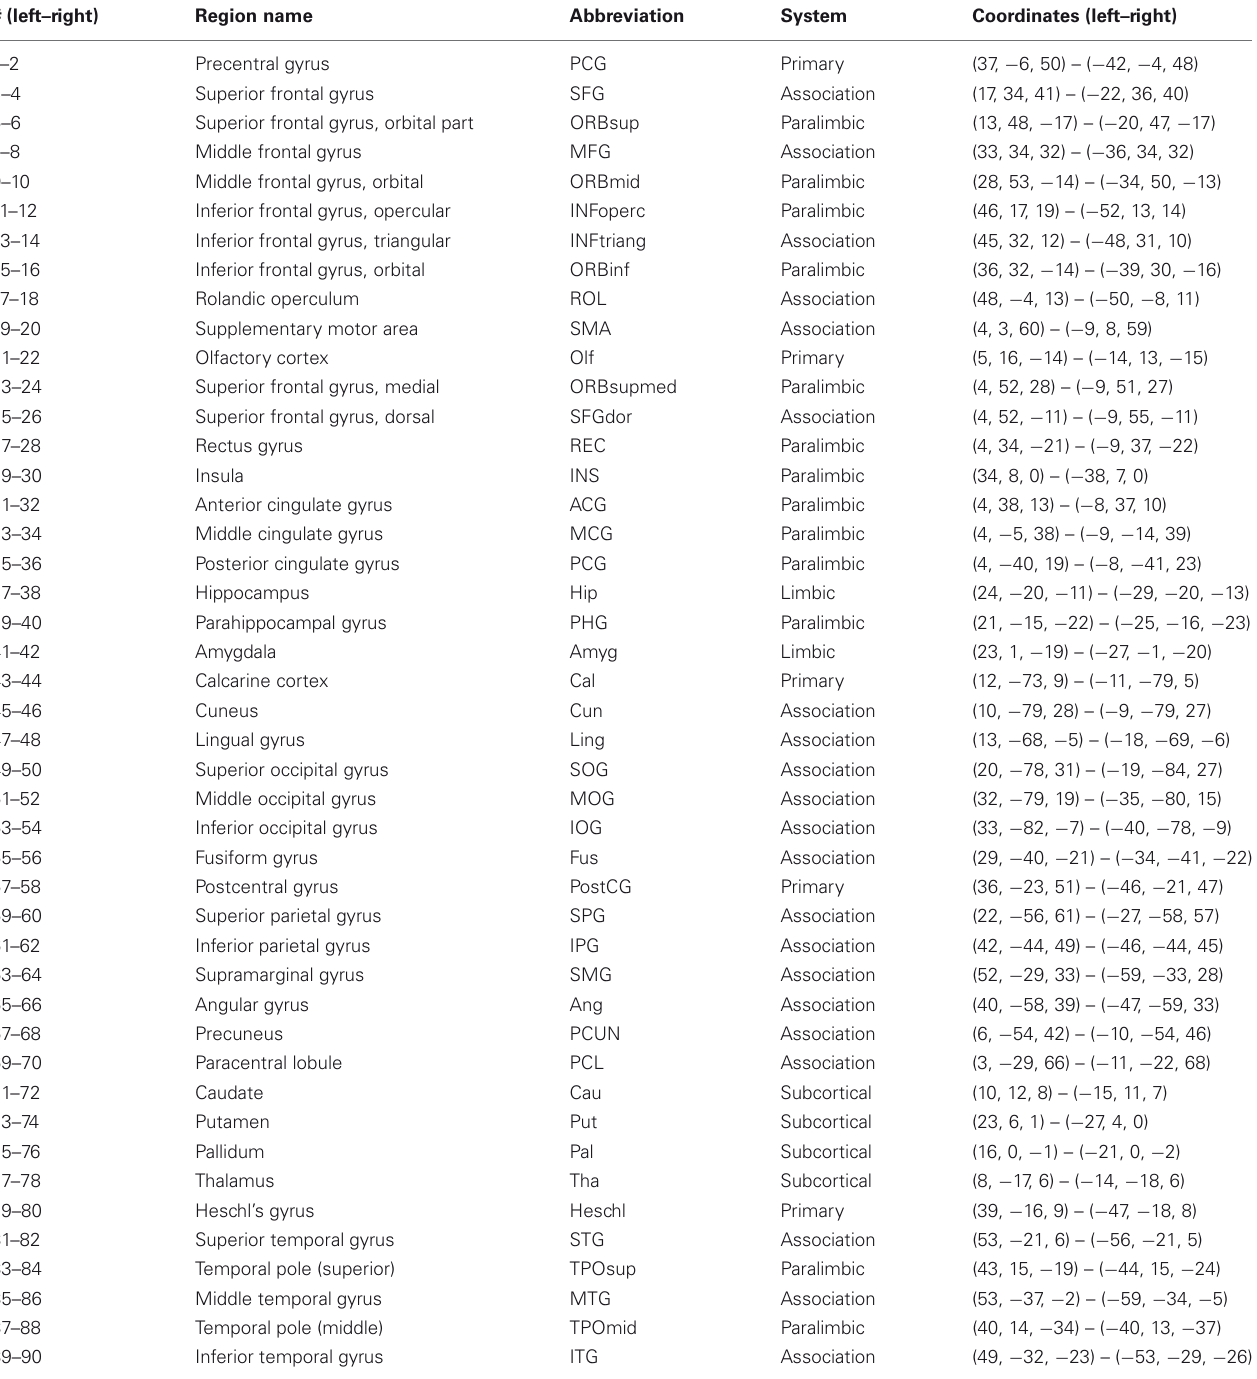
Table 1 | Region number, name, abbreviation, system membership (from Achard et al., 2006), and anatomical coordinates (for the center of mass of the 90 cortical and subcortical regions defined in the AAL